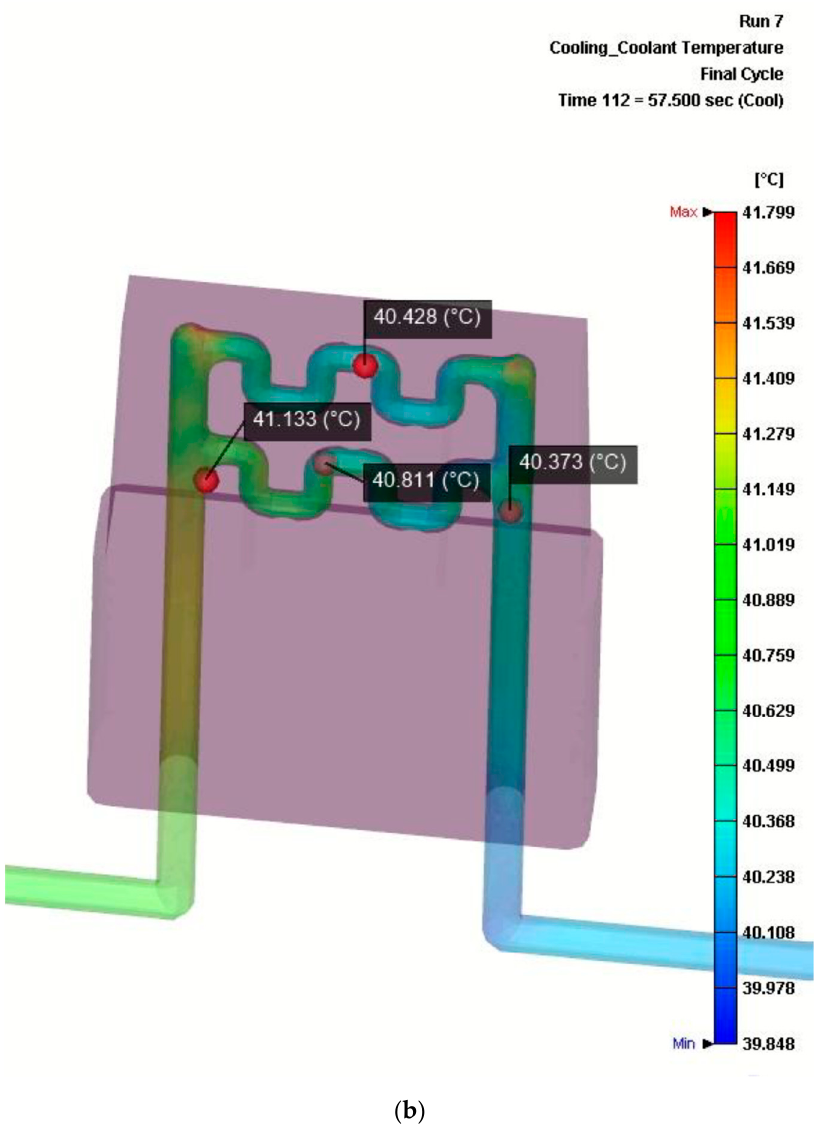
Figure 9. Results of the numerical simulation of the cooling flow obtained at time = 57.5 s with Moldex3d. ( a ) Cooling channel Reynolds number of the redesign of the insert (with conformal cooling channels). ( b ) Temperature distribution of cooling flow in the redesign of the insert (with conformal cooling channels).